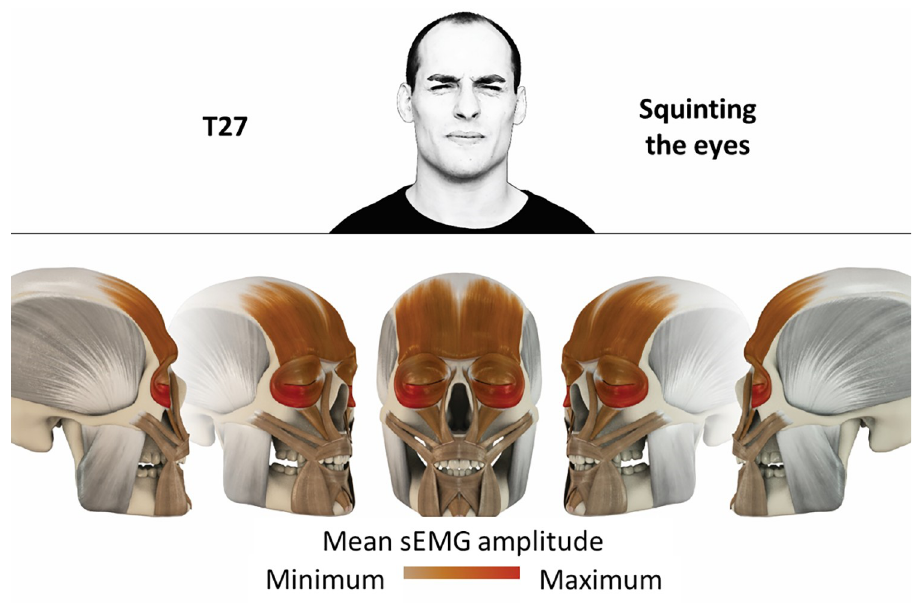
Fig 28. Color-coded facial muscle activation pattern of task T27. Squinting the eyes. Animation by Jonas Laustro¨er.